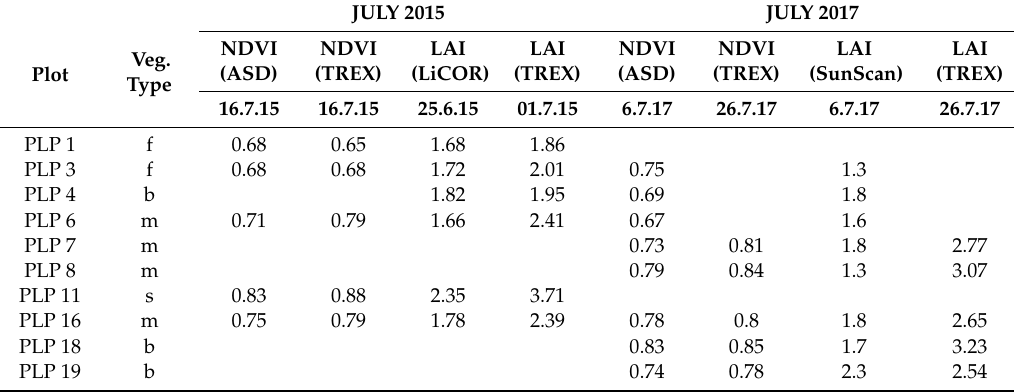
Table 1. Summary of NDVI and LAI measurements conducted in July 2015 and July 2017 compared with the same values extracted from processed Proba-V images with TREX. Vegetation types: f—pristine